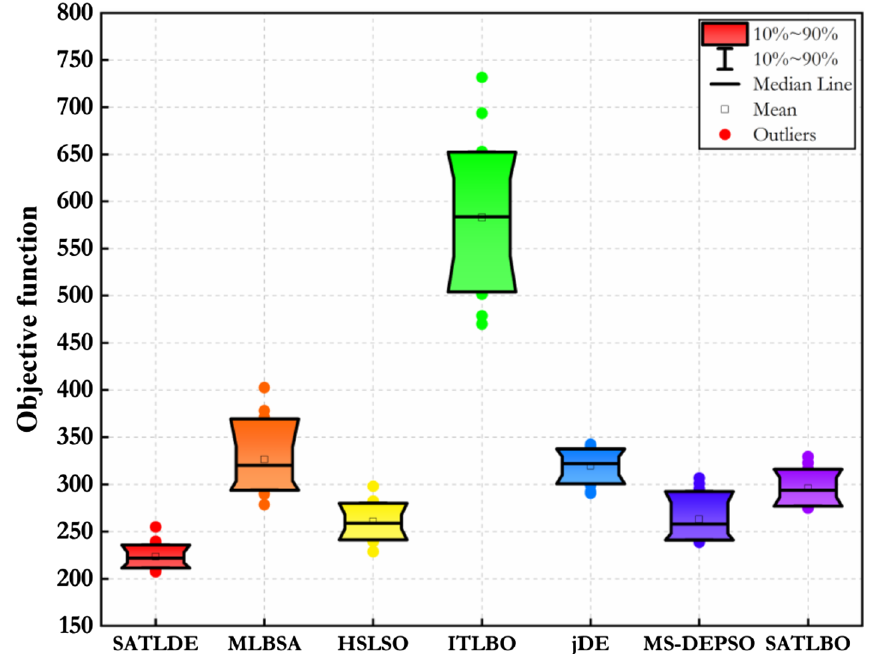
Figure 11. Boxplots of all optimizers for real world multi-reservoir problem.